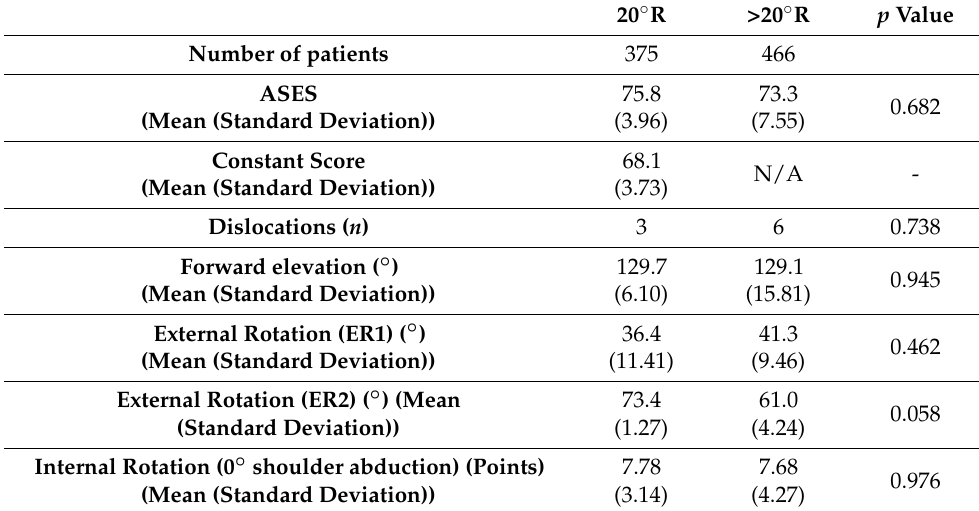
Table 5. Comparison of Groups 2 and